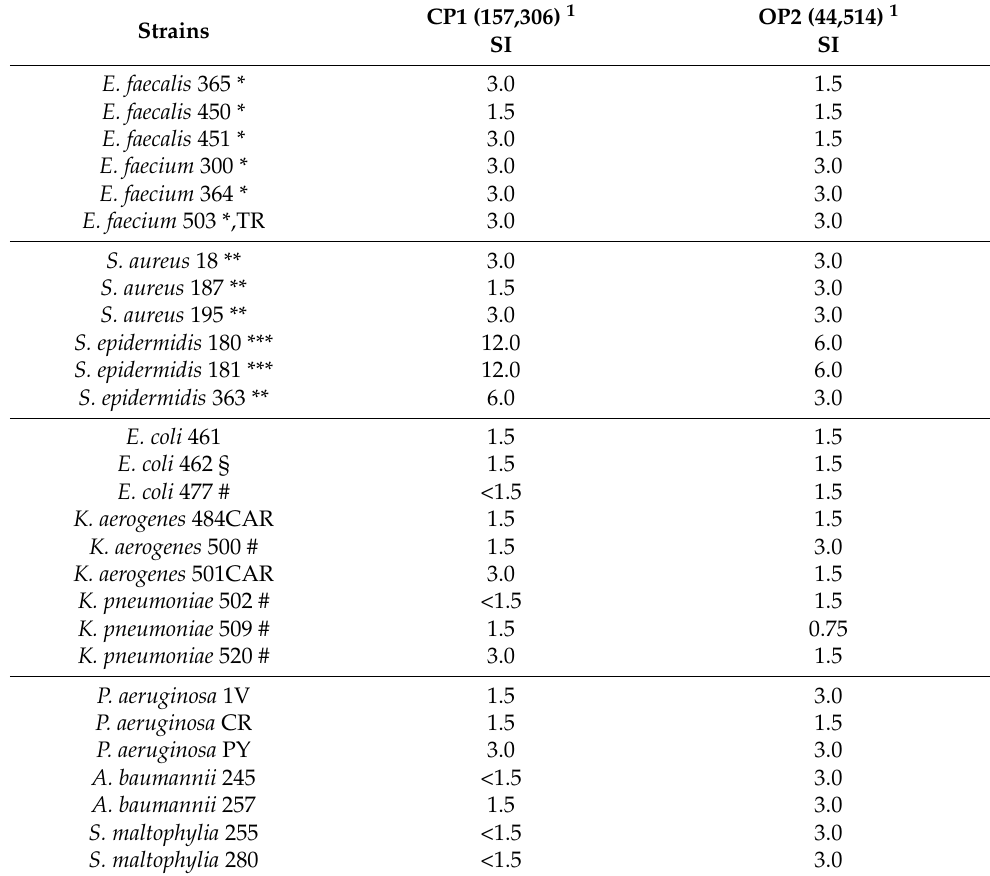
Table 2. MDR clinical isolates against which CP1 and OP2 were tested and related SI values of CP1 and